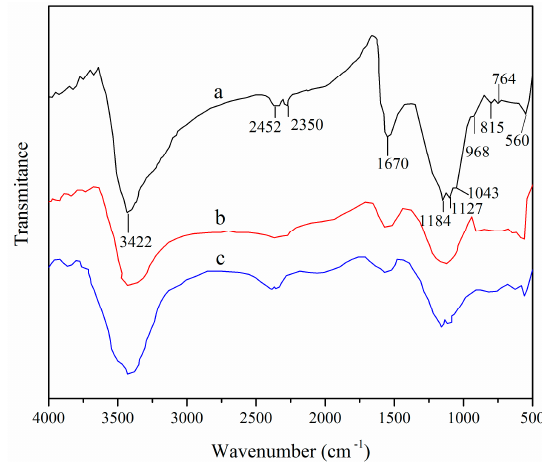
Figure 11. FTIR spectra of XSBLAC ( a ); after adsorption ( b ) and after desorption ( c ) of zinc(II).